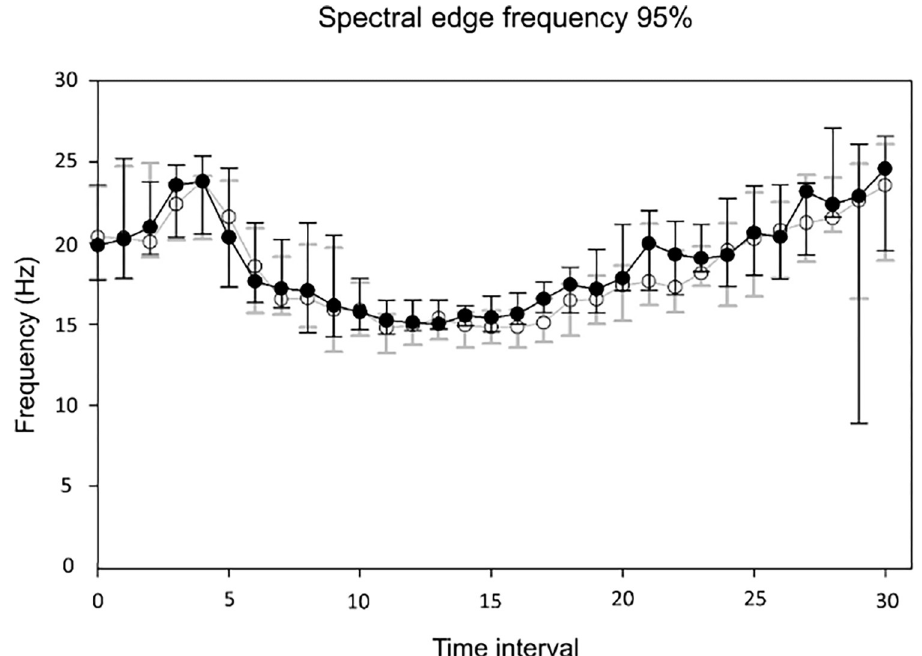
Fig 4. Spectral edge frequency 95% (median and interquartile ranges) -left (white dots) and -right (black dots) at each time interval (TI).